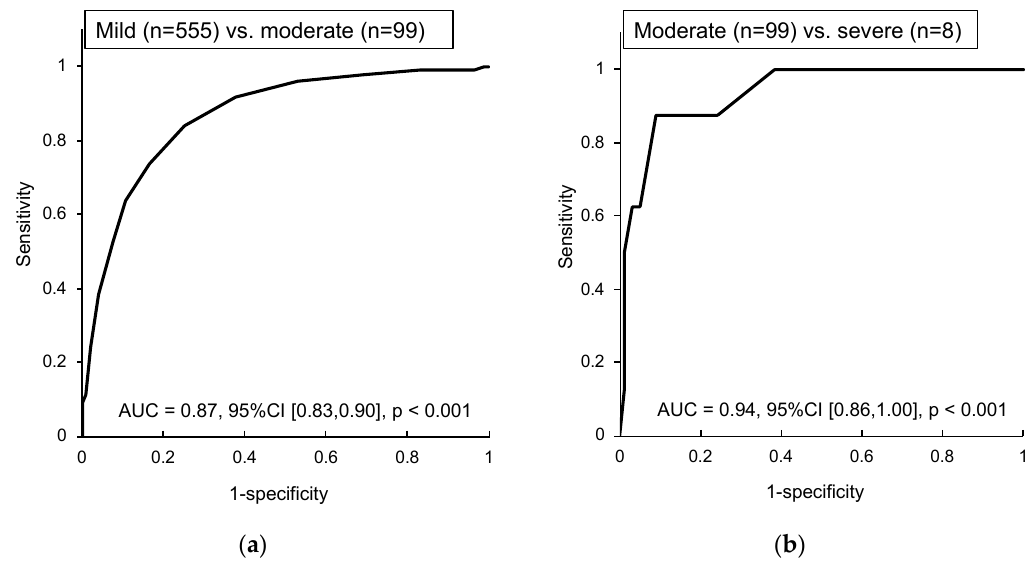
Figure 1. Cutoff point of the AIS for insomnia severity estimated using the receiver–operator curve (ROC): ( a ) ROC at mild vs. moderate levels; ( b ) ROC at moderate vs. severe levels.